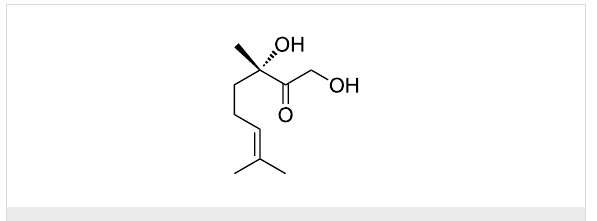
Figure 1: ( S )-1,3-dihydroxy-3,7-dimethyl-6-octen-2-one ( 1 ).